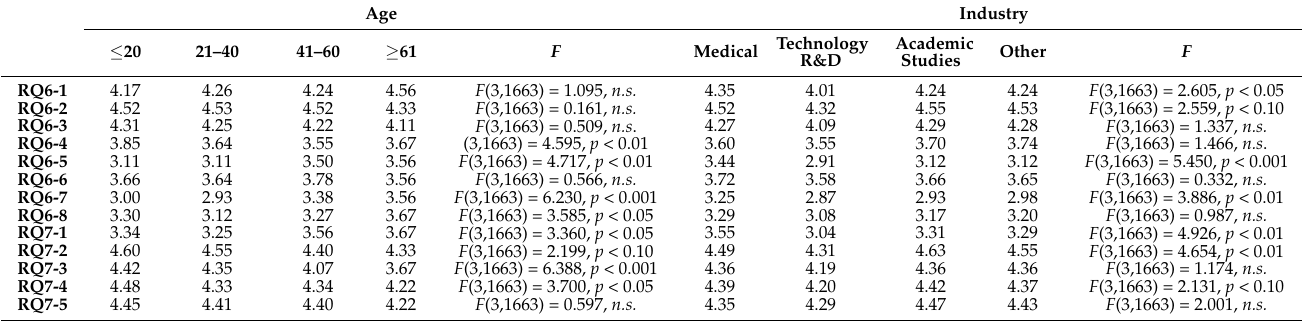
Table 3. Effects of age and occupational background in RQ6 and RQ7